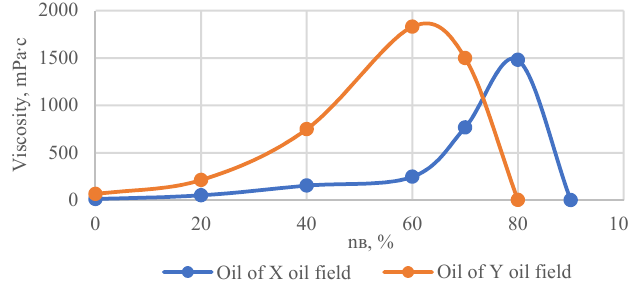
Figure 2. Rheological characteristics of crude oil.